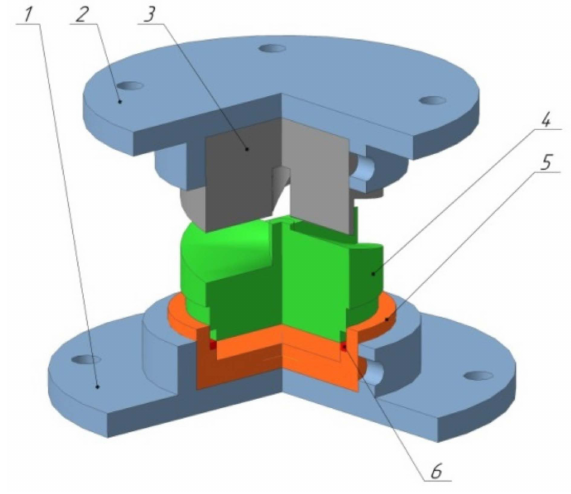
Figure 1. General view of the complete construction: 1—bottom carrier, 2—top carrier, 3—upper striker, 4—lower striker, 5—matrix, and 6—piston